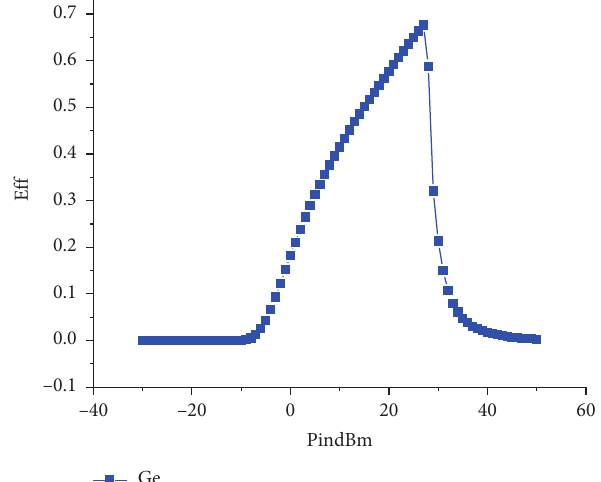
Figure 14: Conversion efficiency of a conventional Ge Schottky diode.